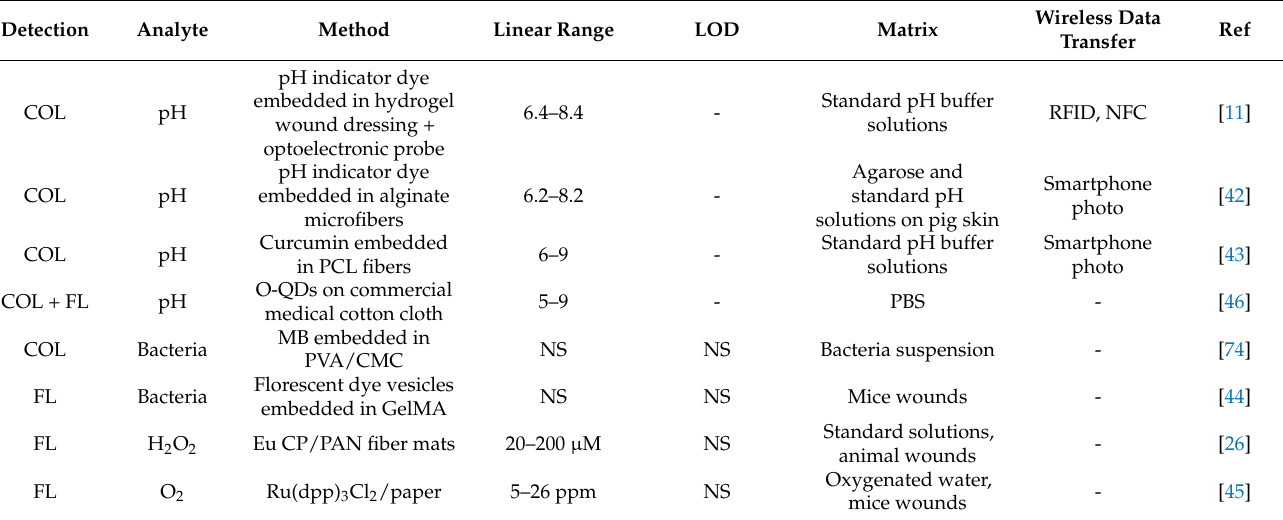
Table 4. Examples of colorimetric and fluorimetric wearable and disposable sensors for wound infection biomarker